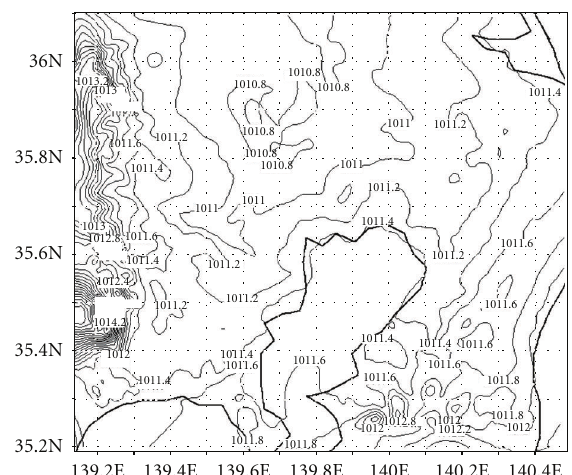
Figure 13: The sea level pressure (mb) simulated by the MM5 model at 12:00 JST August 4, 2005.